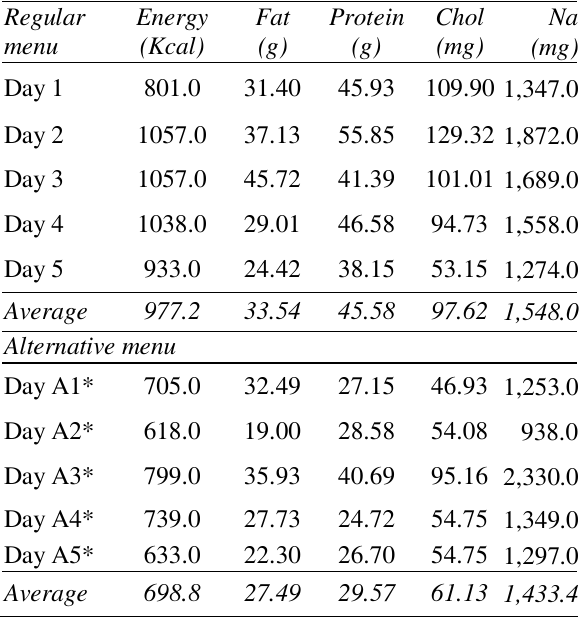
Table 2: Canton Public Schools’ menu analysis for children in grades K-12